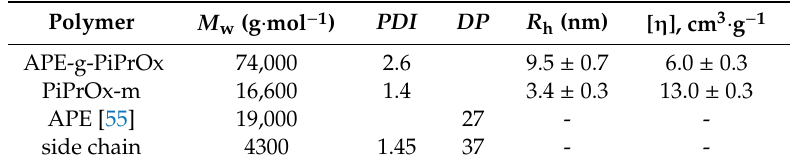
Table 1. Molar mass, polydispersity index (PDI), degree of polymerization (DP) and hydrodynamic characteristics of grafted copolymer APE-g-PiPrOx, linear PiPrOx-m, APE macroinitiator, and abstracted side chains.